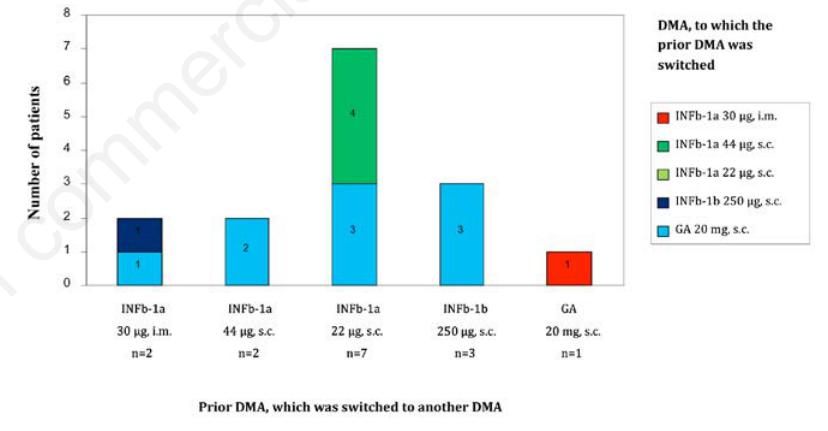
Figure 1. Multiple Sclerosis patients with observed switches and injectable disease mod- ifying agents transitions (treatment duration ≥ 1